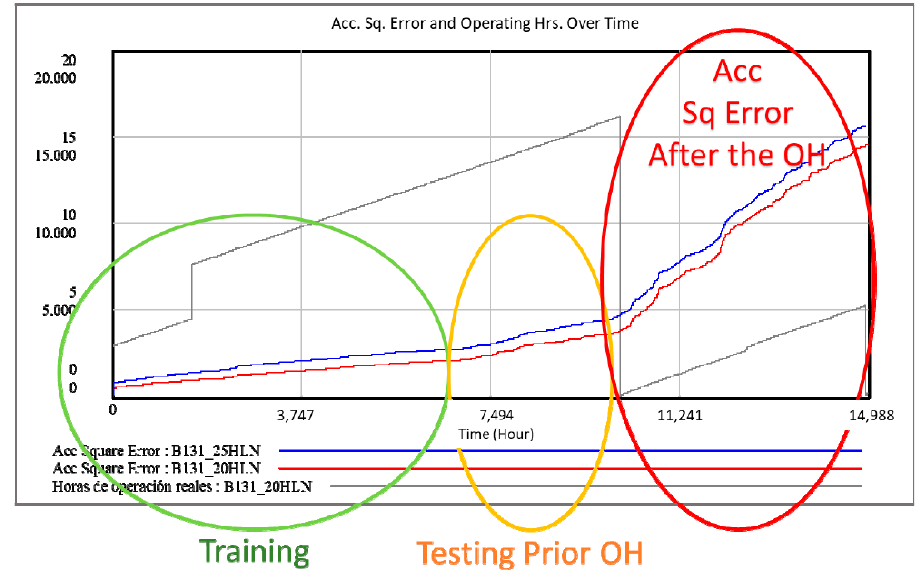
Figure 6. ANN algorithm results for power consumption prediction error in the example presented.